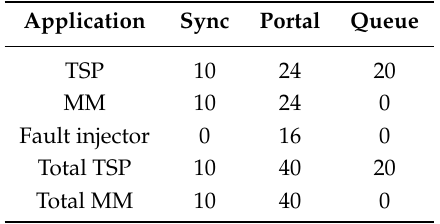
Table A2. NoC connections on applications running NMR-MPar on the